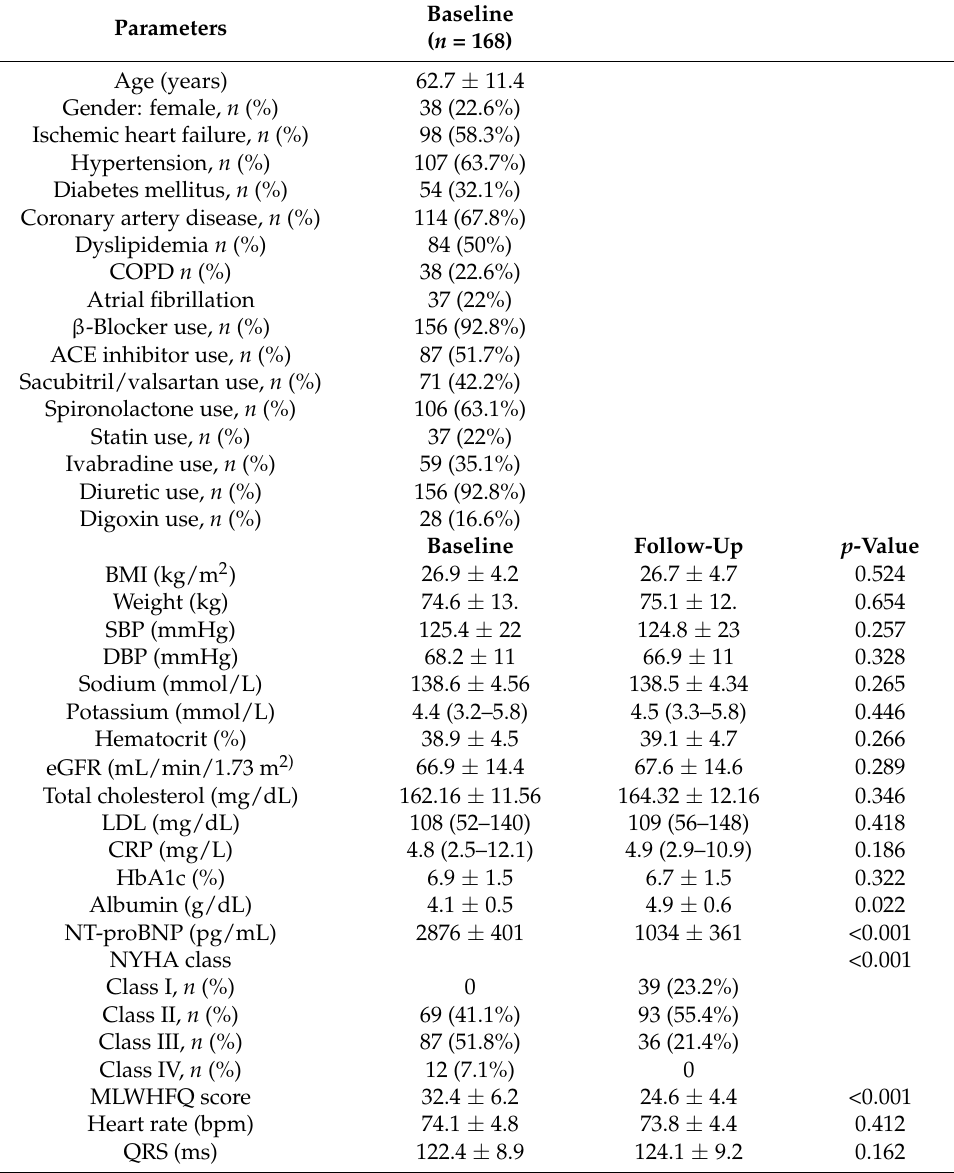
Table 1. Baseline demographic and clinical parameters of the study population. Laboratory and clinical parameters before and after SGLT2 inhibitor